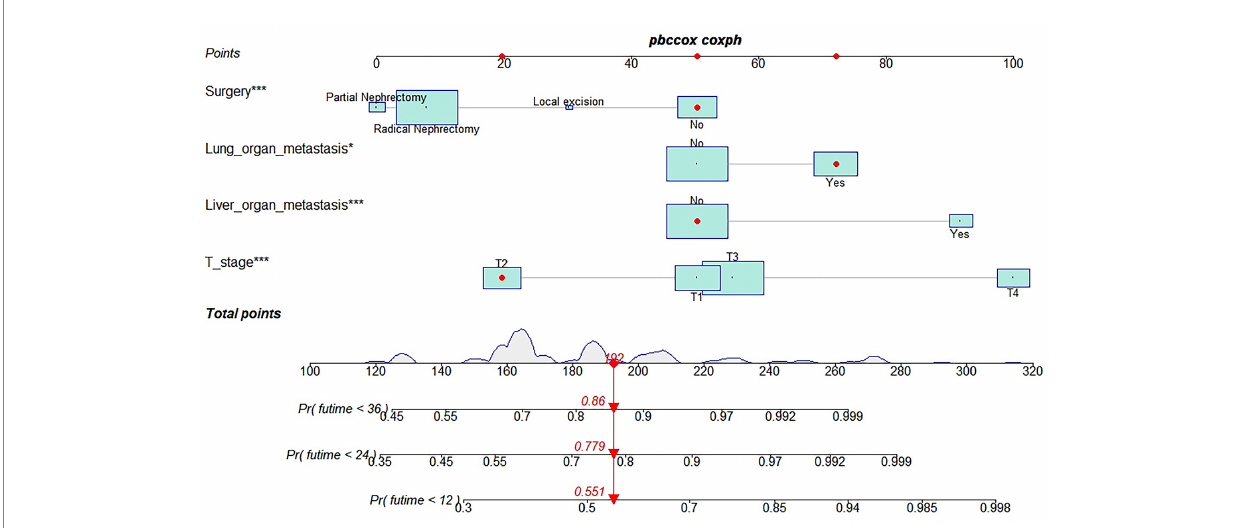
FIGURE 7 Prognostic nomogram in predicting 12-, 24-, and 36-months overall survival (OS) for elderly kidney cancer with bone metastasis (KCBM) patients. *** is the value of significance.